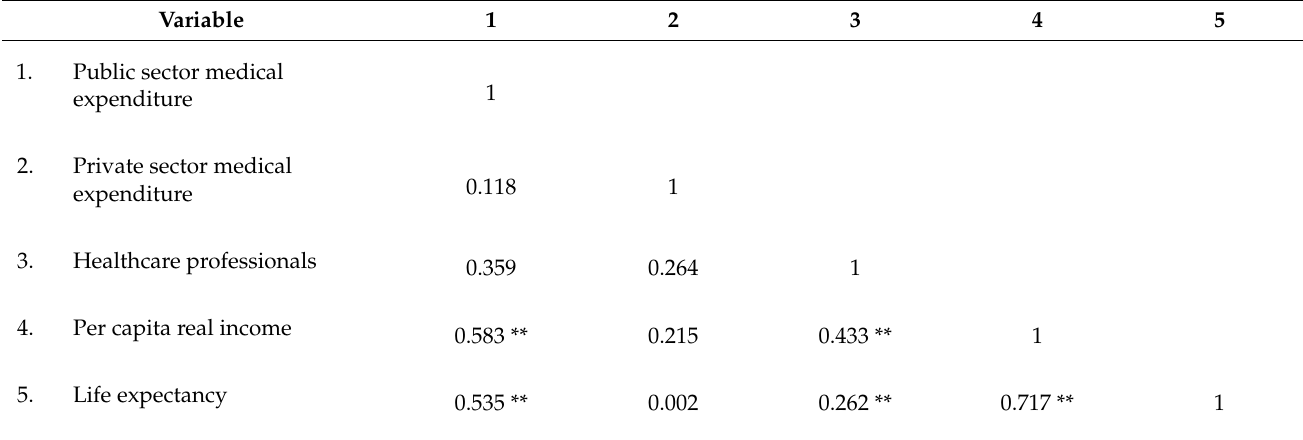
Table 2. Correlation coefficients between inputs and outputs.